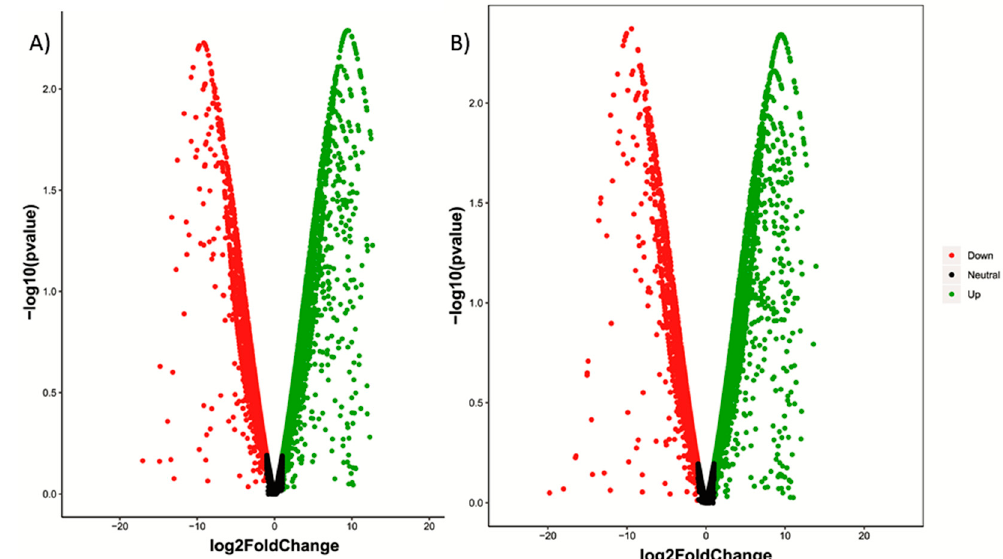
Figure 2. Volcano plot for differential gene expression. Fish feed with ( A ) 40% CHO vs. 20% CHO and ( B ) 60% CHO vs. 20% CHO. Scattered points represent genes: the x-axis is the fold change for the ratio of treated vs. control, whereas the y-axis is the statistic or -Log 10 ( P -value), which shows the probability that a gene has statistical significance in its differential expression. The green dots are thus genes significantly up-regulated after treatment, red dots are genes significantly down-regulated after treatment and black dots are genes significantly neutrally regulated after treatment.